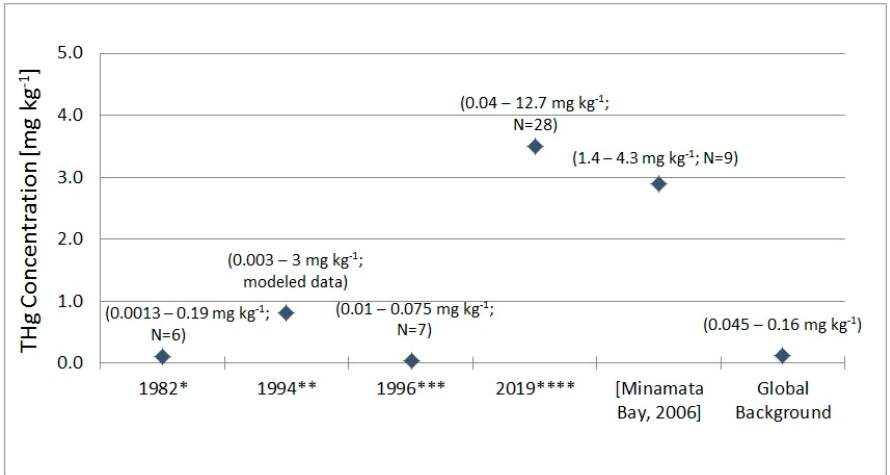
Figure 4. Mean and range of THg concentrations in surface marine sediments of Honda Bay, from 1982 to present. Data from Honda Bay were compared with data from the dredged Minamata Bay (2006) and global background. * Kapauan et al. [20], ** Benoit et al. [24], *** Williams et al. [21], **** This study.